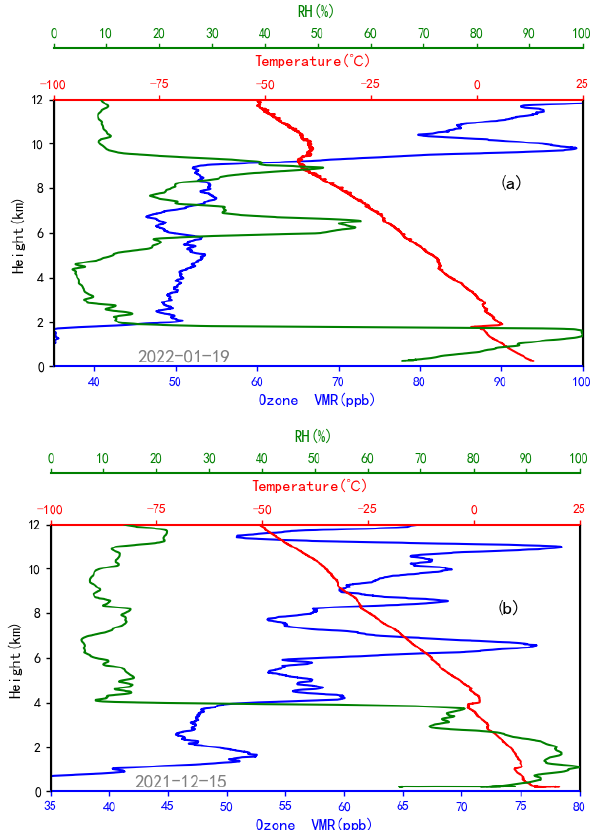
Figure 4. Profiles of ozone VMR (blue lines), RH (green lines), and temperature (red lines) in the troposphere at the Shaowu observation station. 19 January 2022 ( a ) and 15 December, 2021 ( b ).